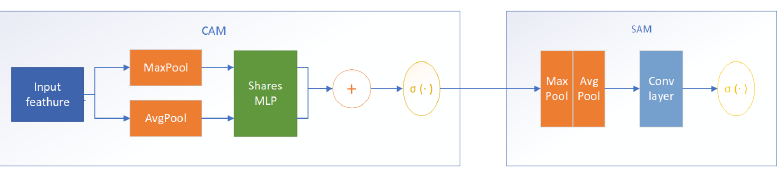
Figure 3. The Convolutional Block Attention Module (CBAM) contains of Channel-attention module (CAM) and Spatial-attention module